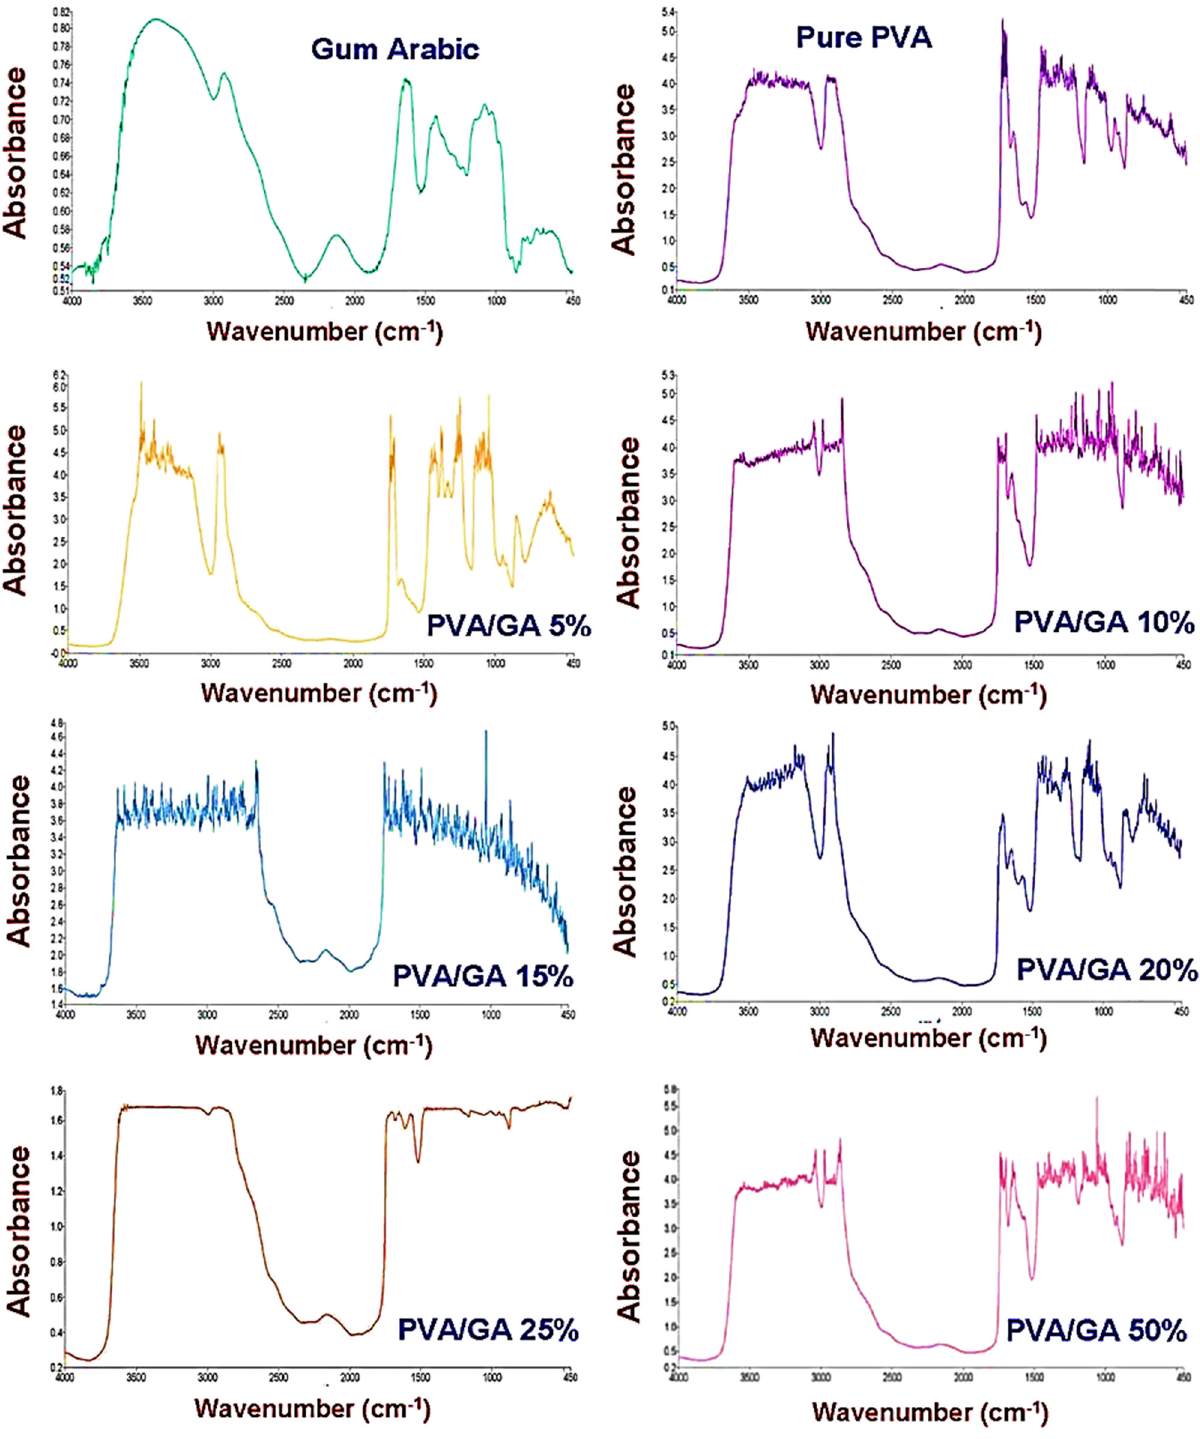
Figure 1: FTIR spectra of GA, PVA hydrogel, and the prepared PVA/GA x . Concentrations ( x ) of GA are from 5% to